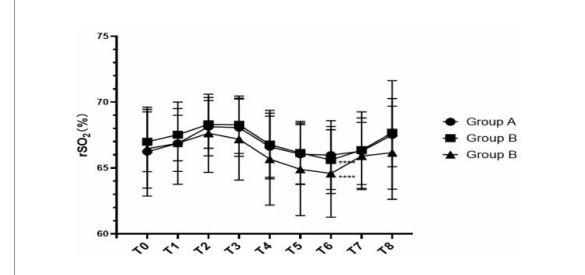
FIGURE1 Line chart of rSO 2 changes at different time